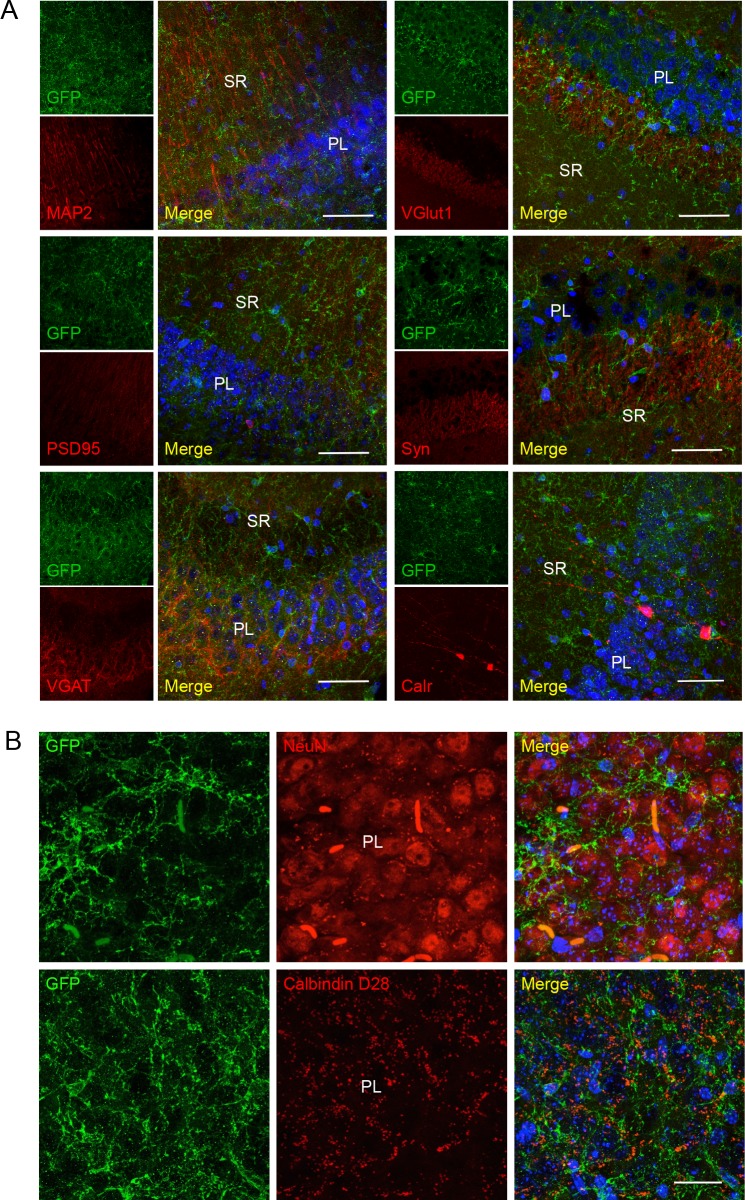
No co-localization of P2X7-EGFP with neuronal/synaptic markers in the CA3 region.(A) Co-labeling with antibodies against GFP (green, ab6556, Abcam), different neuronal or synaptic marker proteins (red), and DAPI (blue). Scale bar: 50 μm. (B) Images taken in the CA3 region at higher resolution. Scale bars: 25 μm., n = 3 animals.